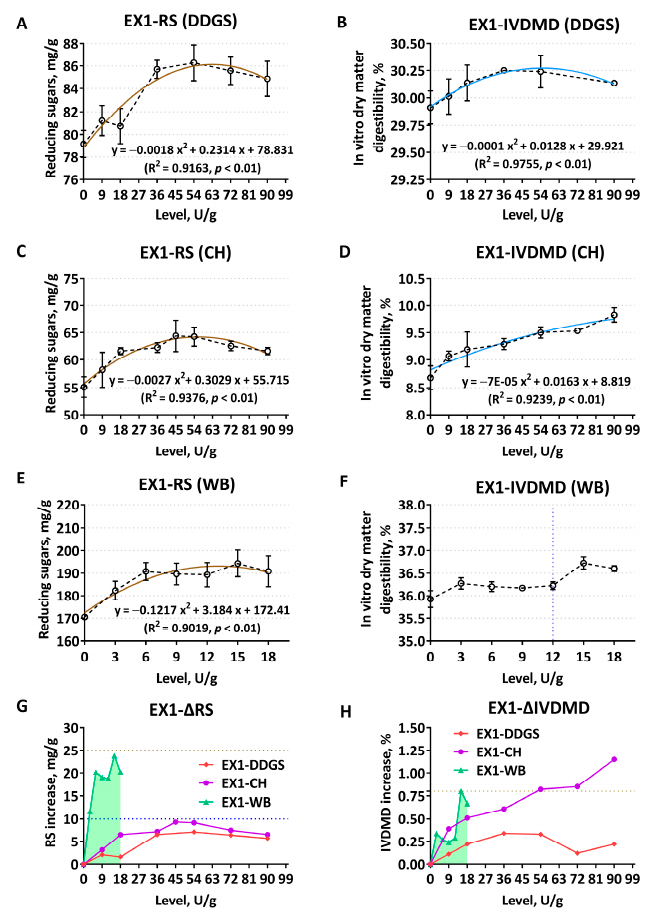
Figure 1. Comparison of enzymatic hydrolysis effects of Aspergillus niger derived xylanase EX1 on different feed ingredients, determined by the release of reducing sugars (RS) and the improvement of in vitro dry matter digestibility (IVDMD). ( A , B ) Corn–soybean meal basal substrates mixed with 5% DDGS; ( C , D ) unitary corn hull (CH) substrate; ( E , F ) unitary wheat bran (WB) substrate; ( G , H ) comparison of the net increase in RS release ( Δ RS, mg/g) and dry matter digestibility ( Δ IVDMD, %), respectively. Polylines directly explain the actual variability of each indicator. The dark brown curves in scatter plots display the RS trend, while the light blue represents the fit of IVDMD. The data are expressed as the means ± SD. When EX2 enzymatically hydrolyzed corn-DDGS, RS enhanced gradually with the